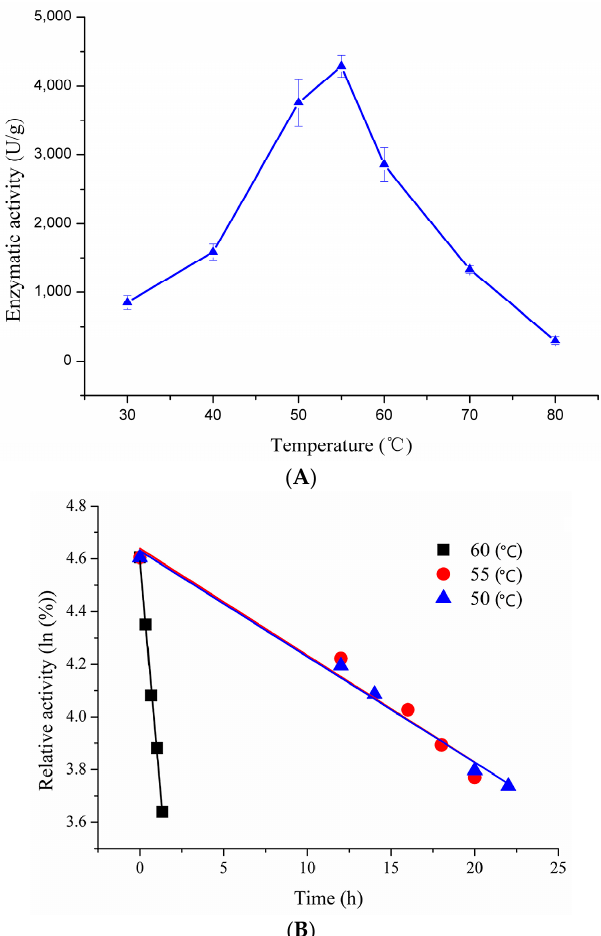
Figure 4. Effect of temperature on activity ( A ) and thermostability ( B ) of pfGDPD. ( A ) The purified pfGDPD was assayed at different temperatures (30–80 °C). Enzymatic activities were tested with bis(para-nitrophenol) phosphate (BpNPP) as substrate. Values are means ± standard deviation from three independent experiments; ( B ) The enzymatic activity was assayed after incubation in different temperatures (50, 55 and 60 °C). Activity was displayed as percentages of the initial activity. The data were fitted to the first-order plots. The half-lives of pfGDPD were calculated as 17.6 h, 17.8 h and 56 min,